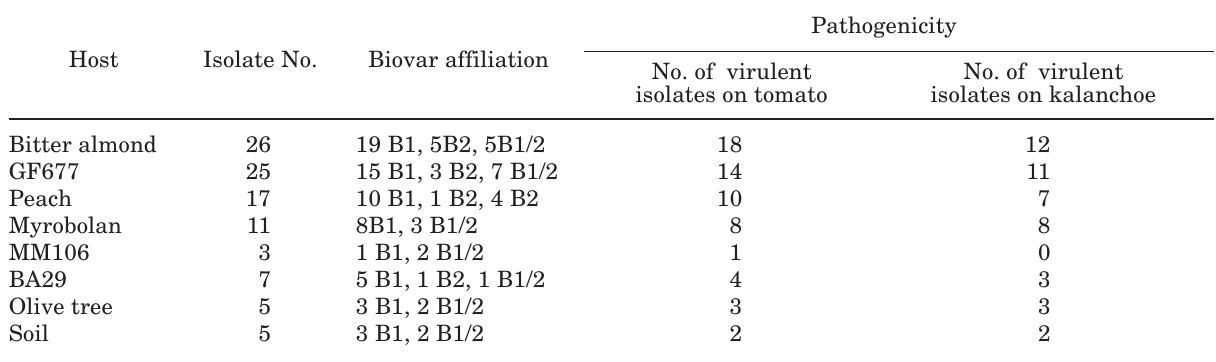
Table 2. Results of biovar affiliation and pathogenicity tests for Agrobacterium